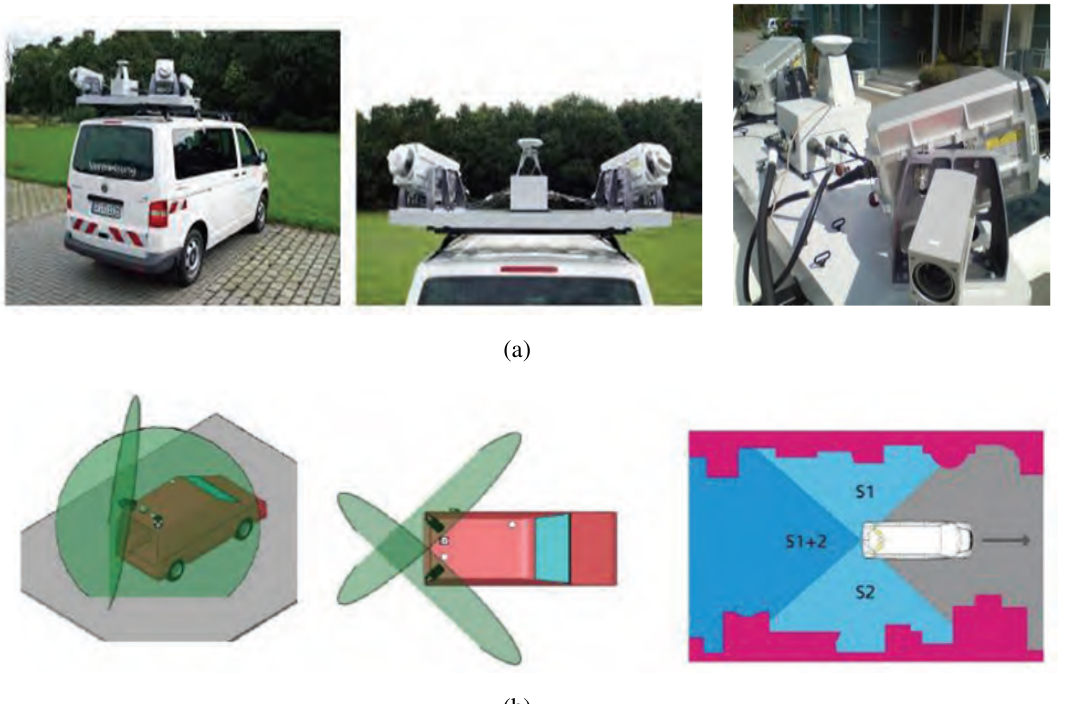
( a ) Optech Lynx LiDAR sensors equipment; ( b ) Optimum orientation of 2 LiDAR